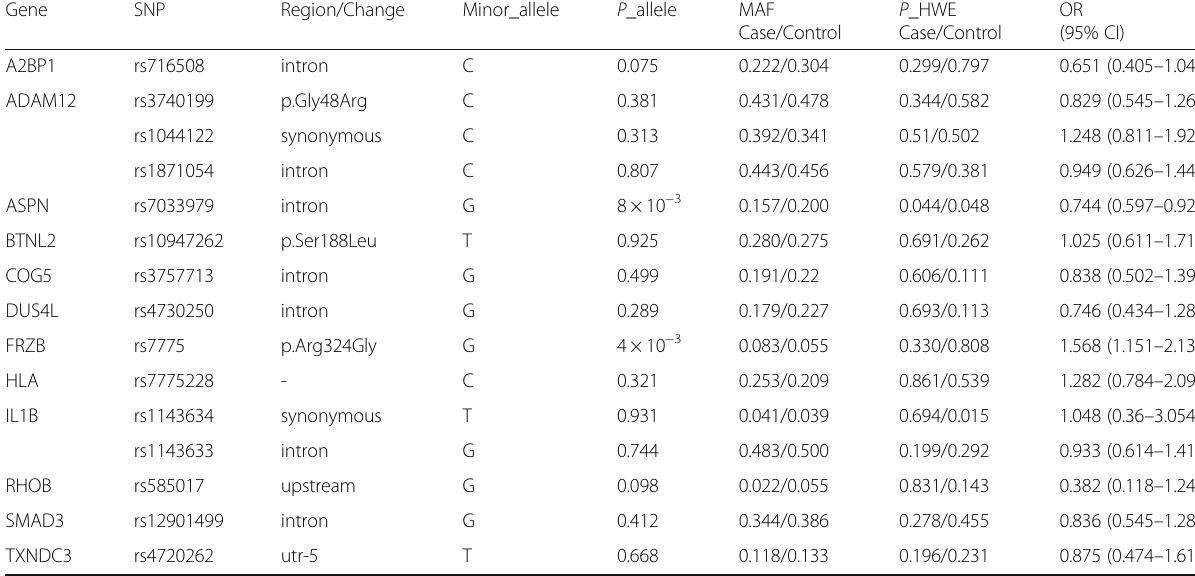
Table 3 Comparison of allele frequencies of the 15 variants between cases and controls